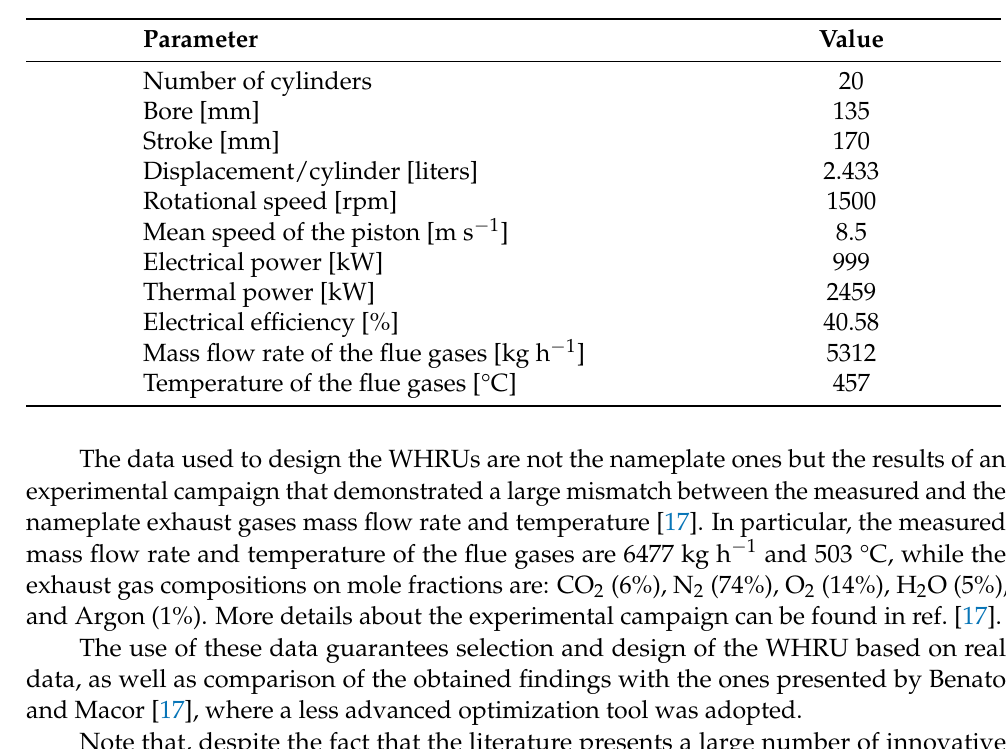
Table 6. Technical data of the bio-gas ICE at design point conditions as given by the manufacturer